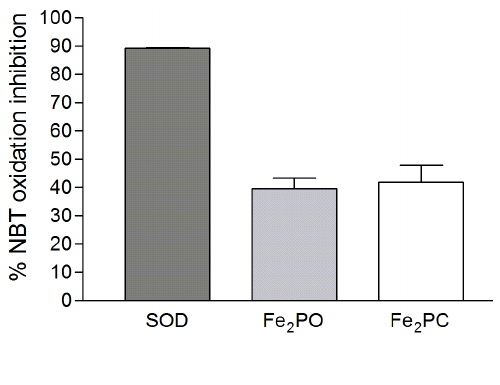
Figure 8. SOD-like activities of Fe oxidation. Bars represent the standard error of the mean (±SEM) of triplicate values.